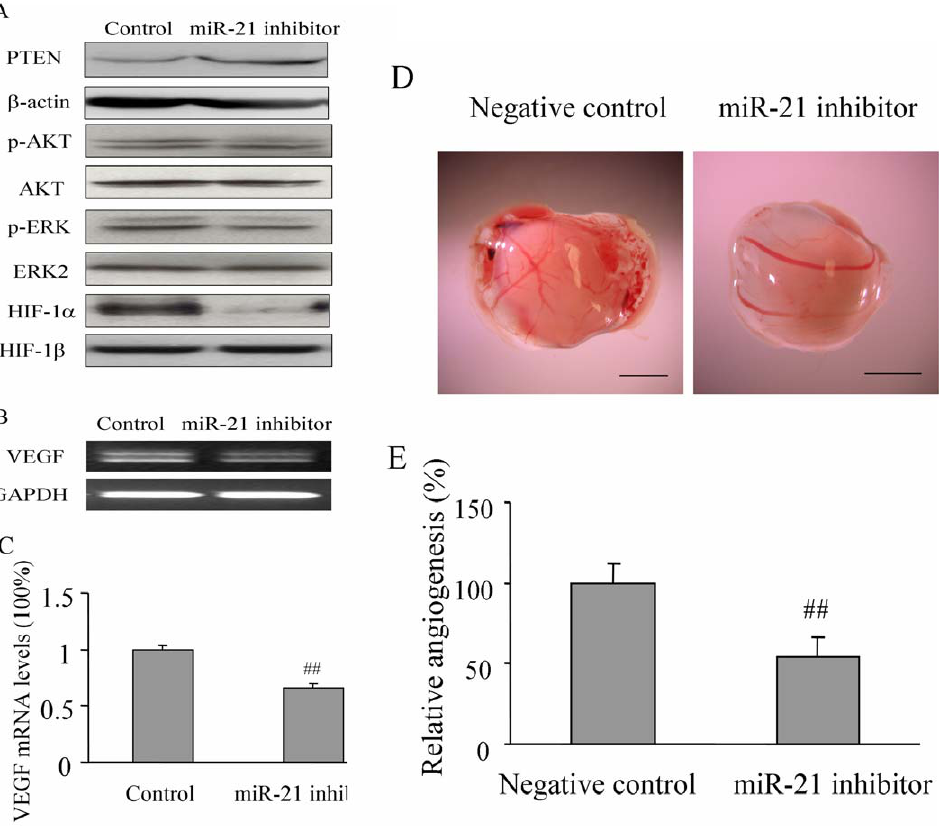
Figure 2. The inhibitor of miR-21 inhibited miR-21-inducing expression of HIF-1 a and VEGF, activation of AKT and ERK1/2, and angiogenesis. (A) The total proteins were prepared 36 h after transfection, and analyzed by immunoblotting for the expression of PTEN, b -actin, p- AKT, AKT, p-ERK1/2, ERK2, HIF-1 a , and HIF-1 b . (B–C) The expression levels of VEGF in the cells described as above were analyzed by RT-PCR (B), and by real-time RT-PCR (C). (D) The cells above were used for angiogenesis assay. Representative plugs from the negative control and miR-21 inhibitor treated groups were shown. Scale , 2 mm. (E) The number of blood vessels were counted from replicate experiments, and normalized to that of the control group as relative angiogenesis. The data are the mean 6 SD from 6 replicate experiments. ## , indicates the significant decrease when compared to that of the control ( p , 0.01).